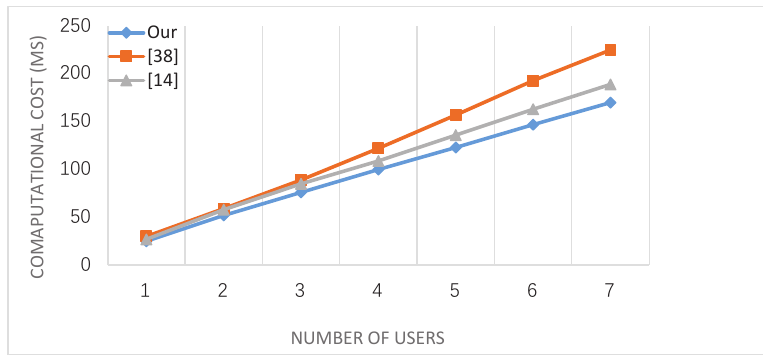
Figure 3. The computational cost